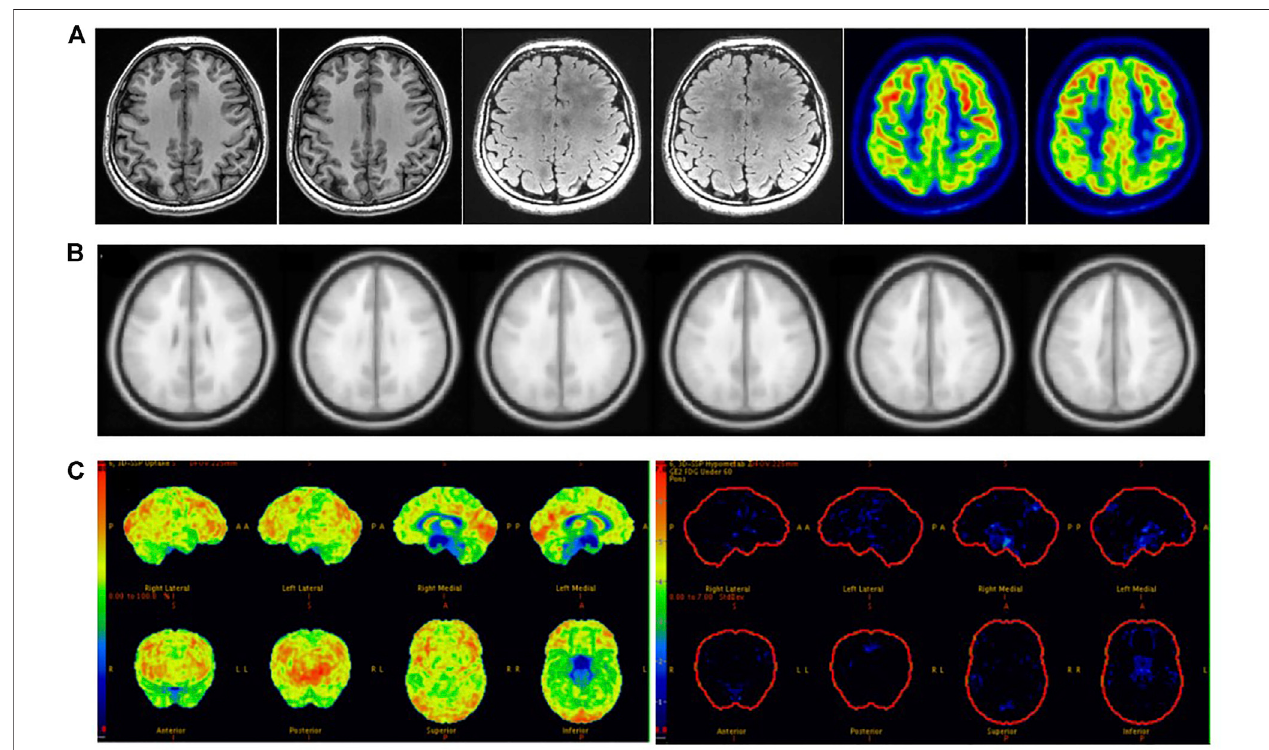
FIGURE 6 | Female, 21 years old, right frontal lobe epilepsy. (A) No structural lesions causing seizures were found at MRI 3.0 T epilepsy-protocol. 18 F-FDG PET obtained abnormal decreased metabolism in the left frontal, parietal and temporal lobes. (B) SPM obtained abnormal metabolism in left temporal lobe while p < 0.005 andK > 100. (C) 3D-SSPobtainedabnormalmetabolisminrightfrontal,doubleparietalanddoubleoccipitallobes.FurtherSEEGexaminationobtainedtheepilepsyfoci originated from right frontal lobe. There had been no seizures for 3 years after surgical resection.